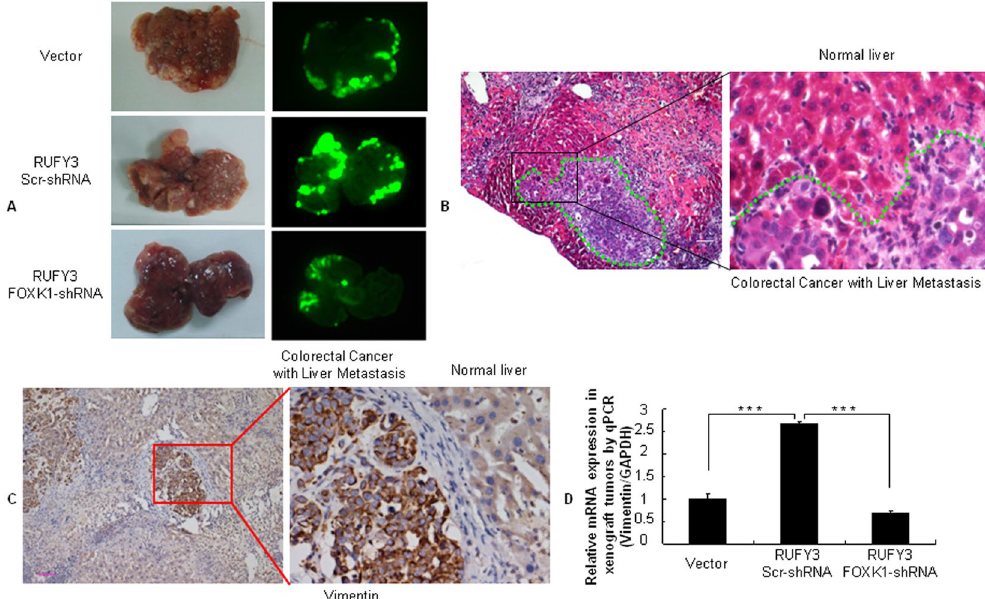
Figure 6. RUFY3 synergizes with FOXK1 to promote tumor metastasis in vivo . ( A ) External whole-body fluorescence images of the liver by injection of LoVo/pEGFP-N1(Vector), LoVo/pEGFP-RUFY3-scr-shRNA and LoVo/pEGFP-RUFY3- FOXK1-shRNA were obtained 30 days after spleen injection. The mice were sacrificed. ( B ) Metastatic cancer tissues were stained with H&E. ( C ) Vimentin expression in the CRC-derived liver metastases was detected by IHC. ( D ) Vimentin expression in tumors derived from LoVo cells was determined by qRT-PCR; *** P < 0.001. Scale bars, 100 μ m in ( B , C